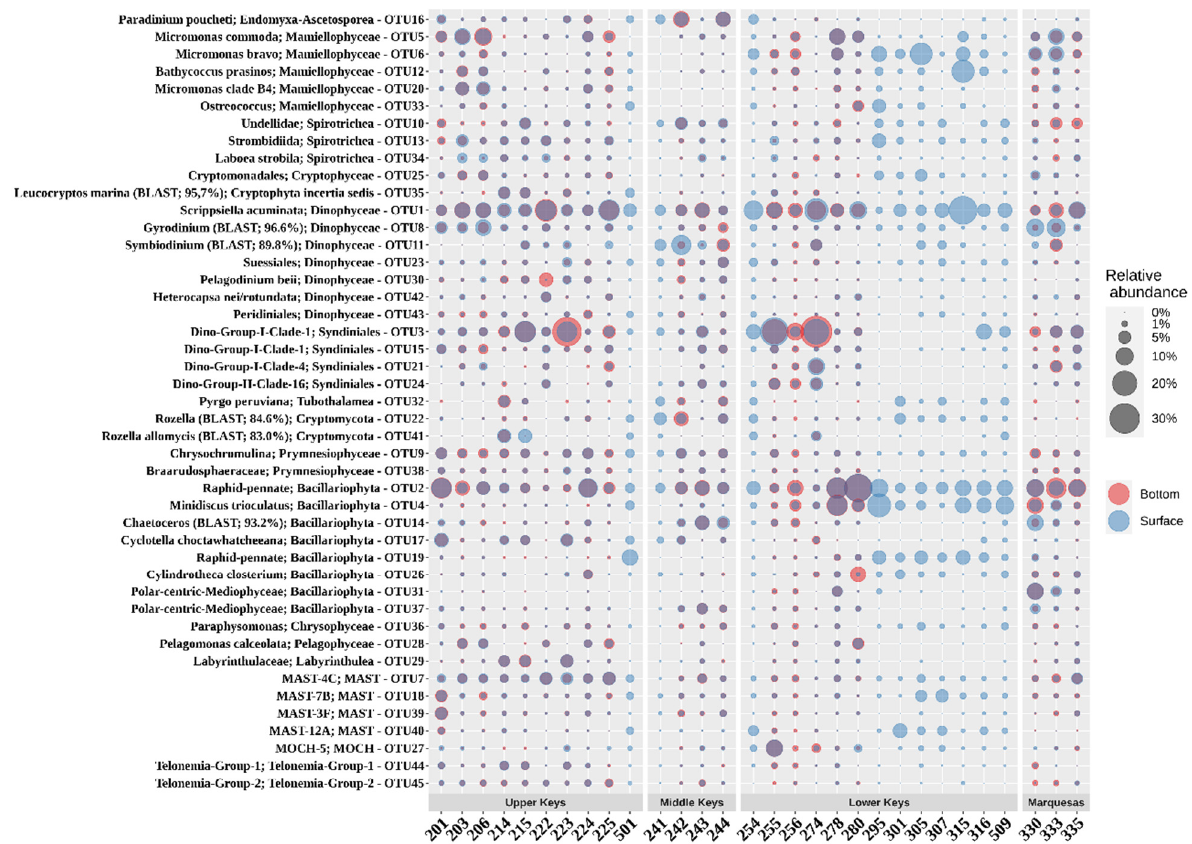
Figure 6. Relative abundance of eukaryotes (genus-level Operational Taxonomic Units, OTUs, clustered at 95% identity) that contributed at least 5% of community composition in at least one sample.